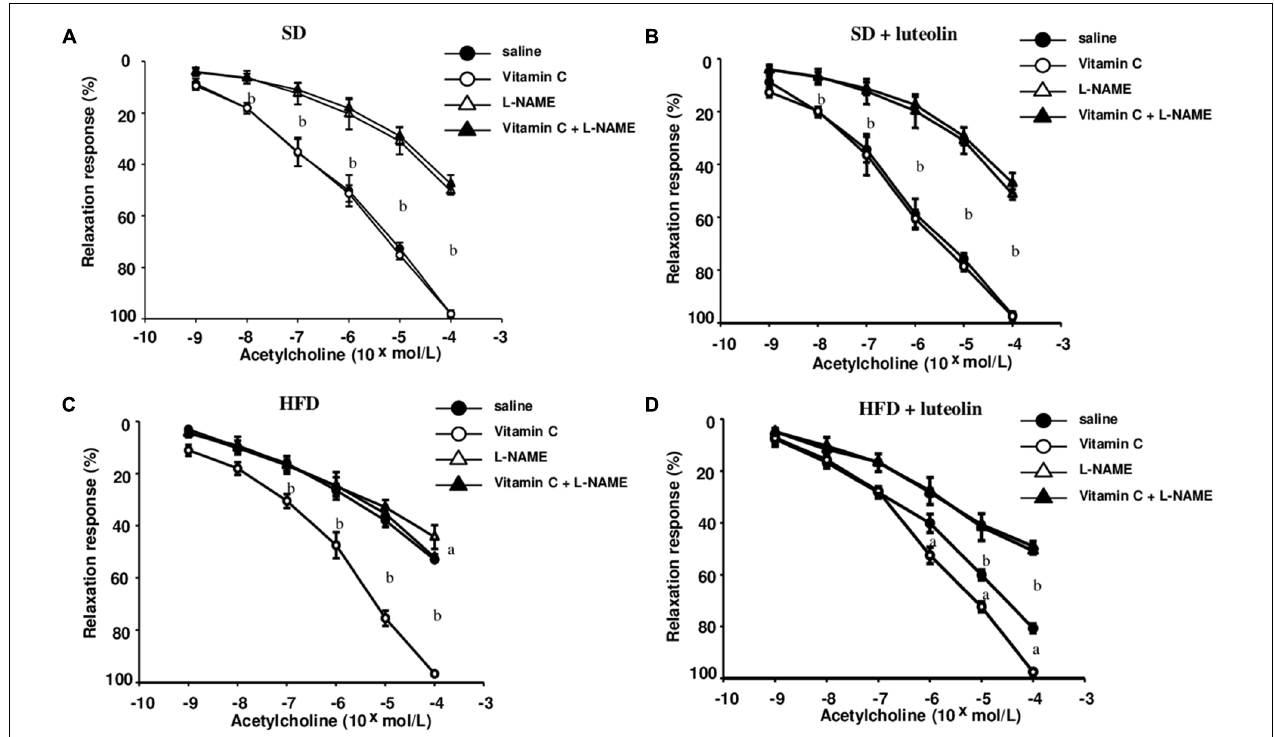
FIGURE 3 | Endothelial-dependent relaxations of mesenteric resistance arteries to acetylcholine in mice fed with SD (A) , SD plus treatment with luteolin (10 mg/Kg/day) (B) , HFD (C) , or HFD plus treatment with luteolin (10 mg/Kg/day) (D) for 8 weeks. Each point represents the mean ± SEM of five animals. a P < 0.05, b P < 0.01 significant difference vs. saline. Statistics: two-way analysis of variance followed by Newman–Keuls test.